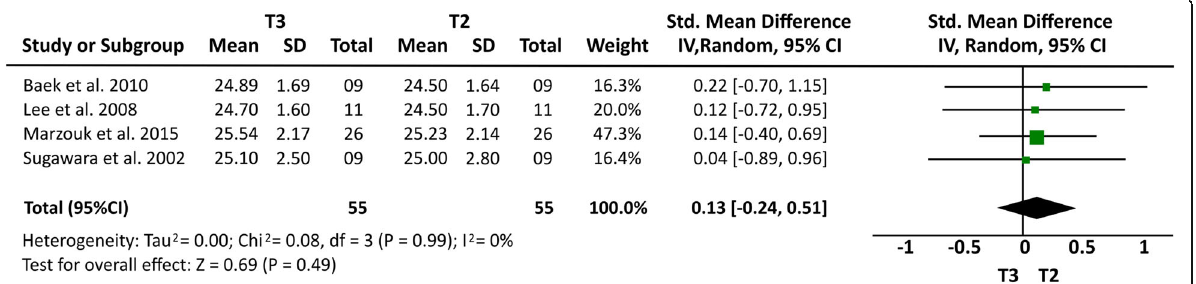
Fig. 3 Forest plot U6-PP difference between T2 and T3 in patients who used TADs for molar intrusion after 1-year follow-up. 95% confidence interval and 95% prediction interval